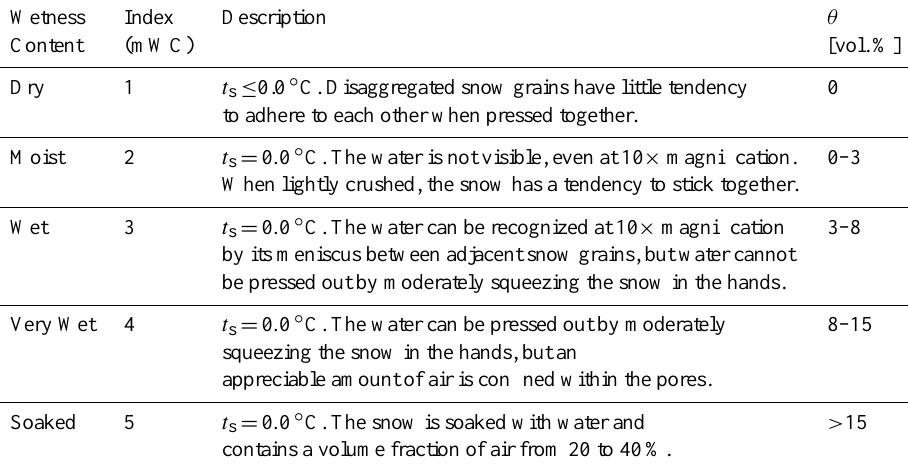
Table 1. Hand test for the qualitative estimation of liquid water content (mWC) and the approximate range of liquid water content ( θ ). The detailed description is taken from the International Classification of Seasonal Snow on the Ground (Fierz et al., 2009, p. 8). This classification is also used in Swiss observational guidelines (WSL, 2008). Half index classes may also be used. t s – snow